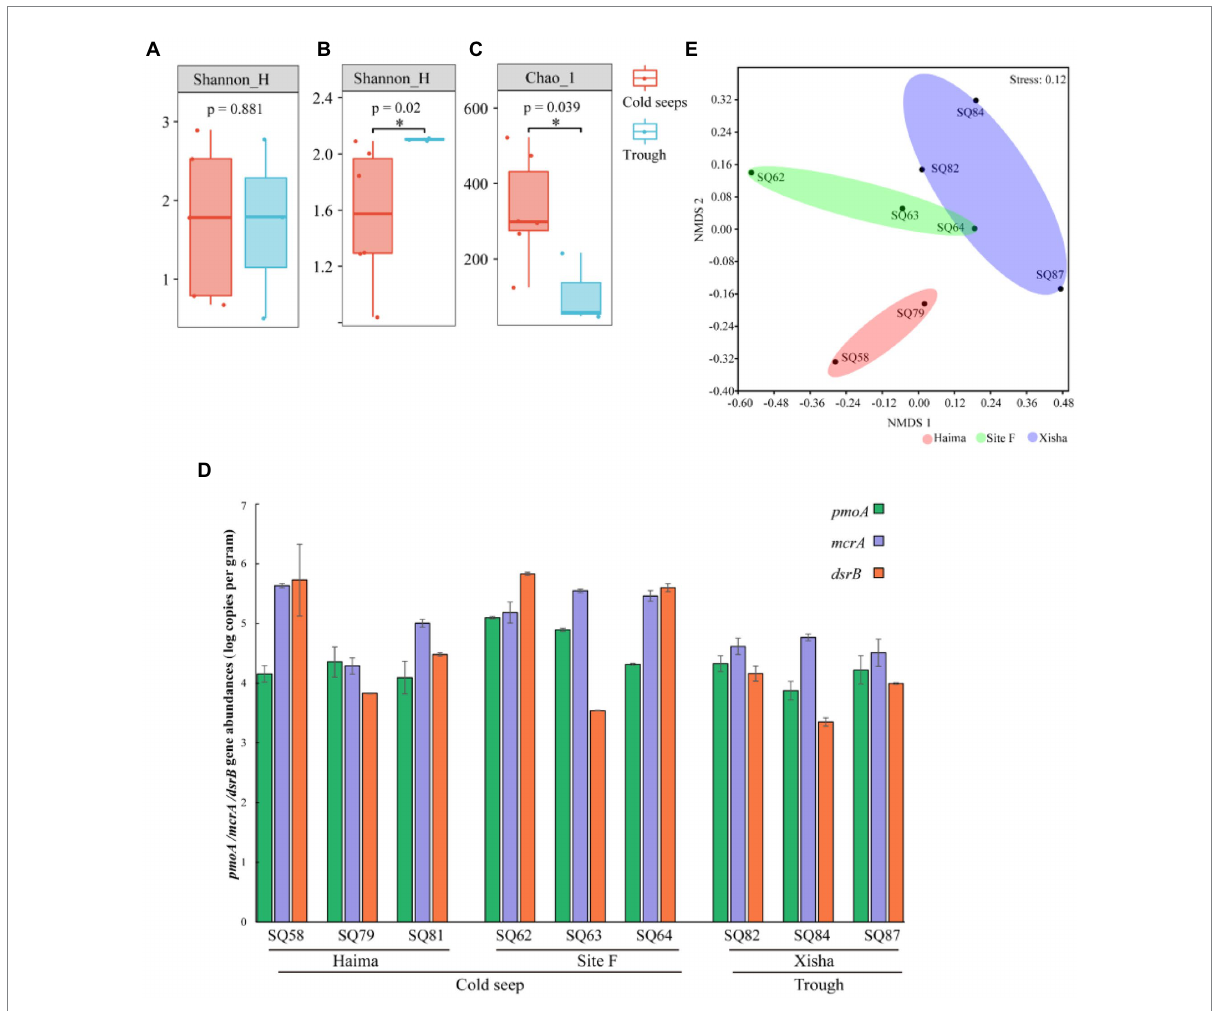
FIGURE 5 The averaged alpha diversity in different regions for mcr A (A) , pmo A (B) and dsr B (C) genes (* p < 0.01); Gene copy numbers (log copies in wet sediment weight) (D) and three functional genesnon-metric multidimensional scaling (NMDS) plot of different functional genes (E)